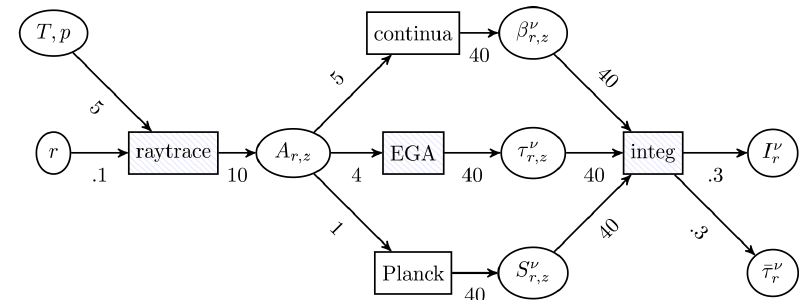
V100 GPUs (NVIDIA, 2017), one of which was used for benchmarking. A PCIe gen3 16 × interface connects CPUs and GPUs. The CUDA runtime and compiler version are 10.1.105, while GCC version 8.3.0 was employed to com- pile the CPU code. In the study of Baumeister et al. (2017), we analyzed the performance of the GPU implementation of JURASSIC for nadir applications. Here, we selected the limb geometry as a test case (see Fig. 6). While in the nadir geometry ray paths typically comprise 160 path segments (assuming an up- per height of the atmosphere at 80 km and default vertical sampling step size of 500 m), the limb geometry produces up to about 400 segments per ray path. Ray paths passing only through the stratosphere feature fewer segments than ray paths passing by close to the surface. Tropospheric ray paths are also subject to stronger refractive effects, bending them towards the Earth’s surface. In the limb test case consid- ered here, the number of segments along the ray paths varies between 122 and 393. In this assessment, we aim for rather extensive coverage of the mid-infrared spectral range. By means of line-by-line calculations with RFM, we prepared emissivity look-up ta- bles for 27 trace gases with 1 cm − 1 spectral resolution for the range from 650 to 2450 cm − 1 . Vertical profiles of pressure, temperature, and trace gas volume mixing ratios for midlat- itude atmospheric conditions were obtained from the clima- tological data set of Remedios et al. (2007). In order to verify the model, we continuously compared GPU and CPU calculations during the development and op- timization of JURASSIC-GPU. For the test case presented in this study, it was found that the GPU and CPU calcula- tions do not provide bit-identical results. However, the rel- ative differences between the calculated radiances from the GPU and CPU code remain very small ( ≤ 10 − 5 ), which is orders of magnitudes smaller than typical accuracies of the EGA method itself ( ∼ 1 %) and considered suitable for most practical